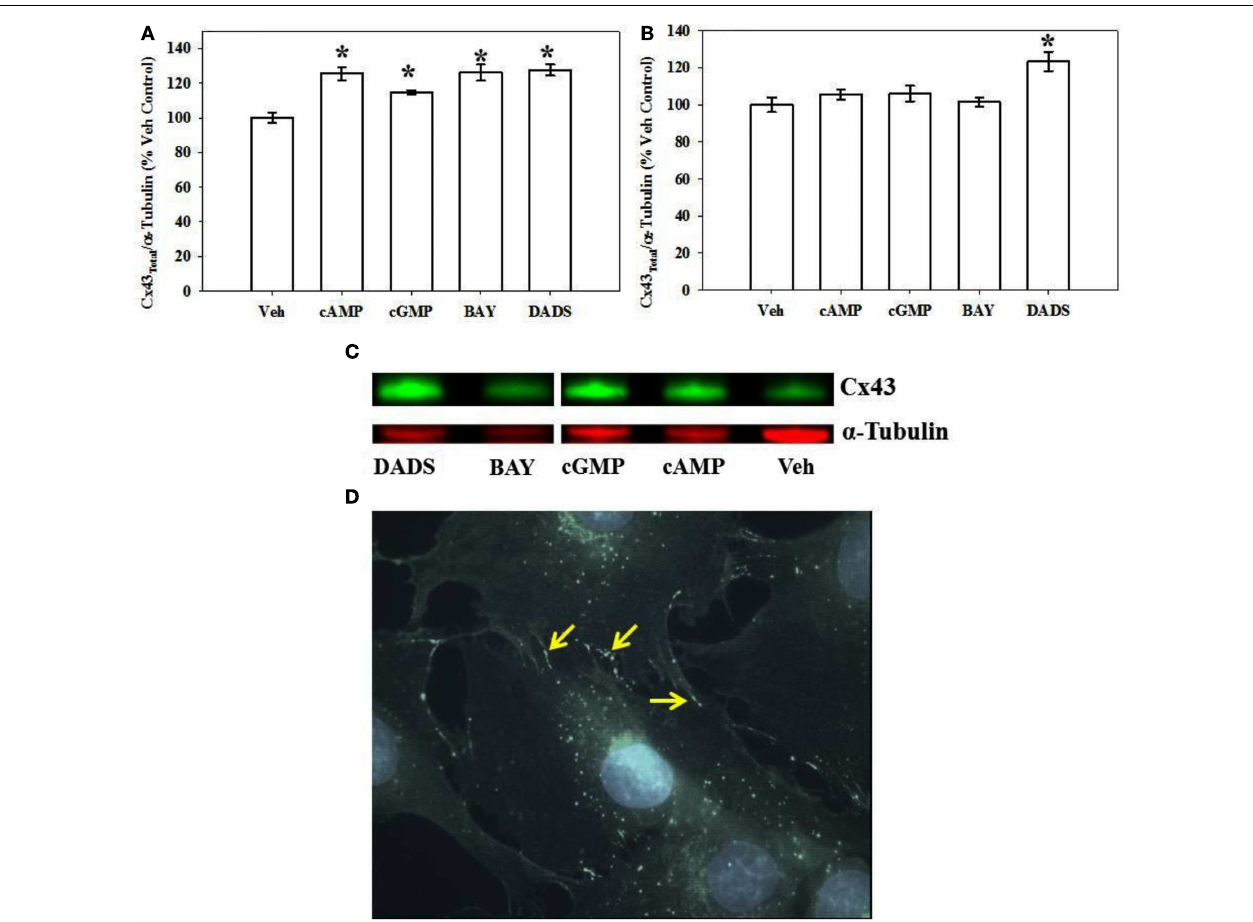
treatment. Student–Newman–Keuls method for multiple comparisons following one-way ANOVA was used. * p < 0.05 compared with normalized vehicle controls. (C) A representativeWestern blot showing total Cx43 in green and α -tubulin in red using IR-labeled antibodies.These data were obtained from a singleWestern blot with a column (unrelated to the current study) removed for clarity. (D) Photomicrograph of confluentVSMCs following immunocytochemical staining for total Cx43. Punctate appearance of Cx43 indicating the presence of gap junctions is predominantly at cell-to-cell contacts (indicated by